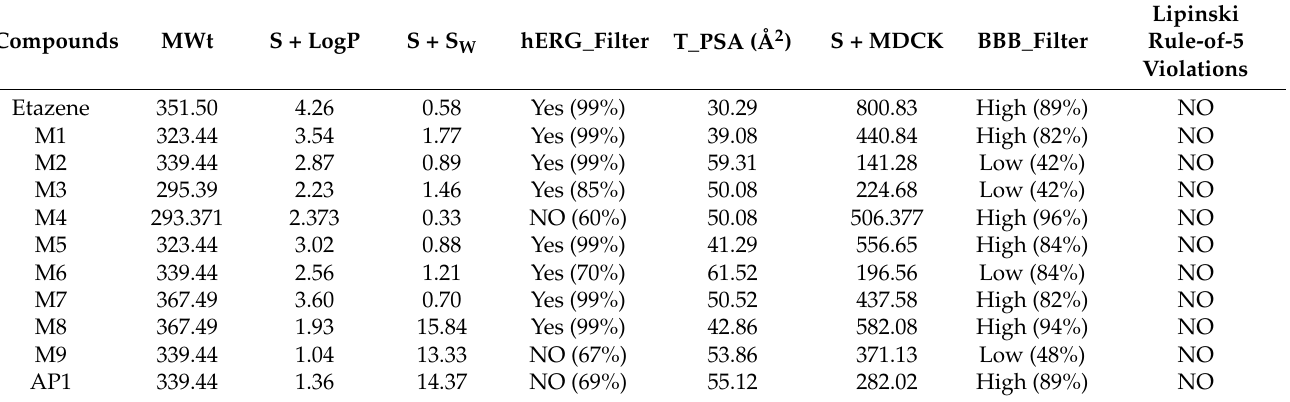
Table 2. Physicochemical properties of etazene and its metabolites calculated using the ADMET predictor.